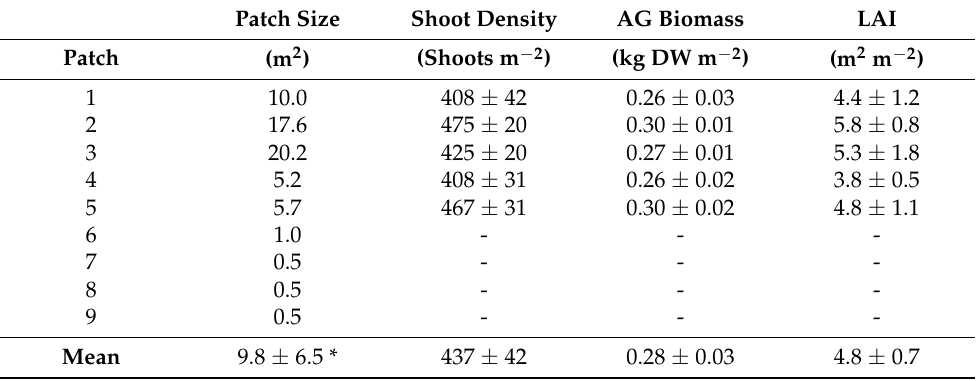
Table 2. Population descriptors: shoot density (shoots m − 2 ), aboveground (AG) biomass (kg DW m − 2 ) and leaf area index (LAI; m 2 m − 2 ) of the newly reported P. oceanica population (36 ◦ 18 (cid:48) 38.80 (cid:48)(cid:48) N, 5 ◦ 15 (cid:48) 15.13 (cid:48)(cid:48) W) studied during August 2021. Data are represented as mean ± standard deviation.